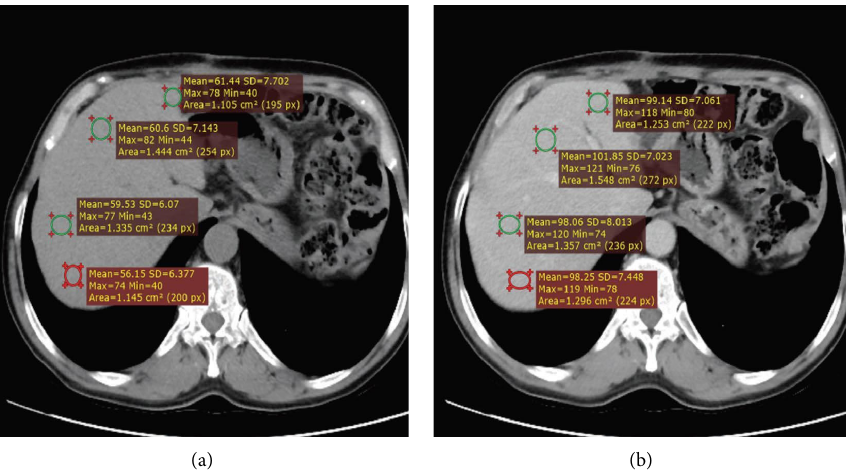
Figure 1: Axial precontrast (a) and postcontrast portal venous phase (b); axial CTscans at the same level taken in TASH, 2022 G.C, show mean hepatic attenuation at the four diferent locations of